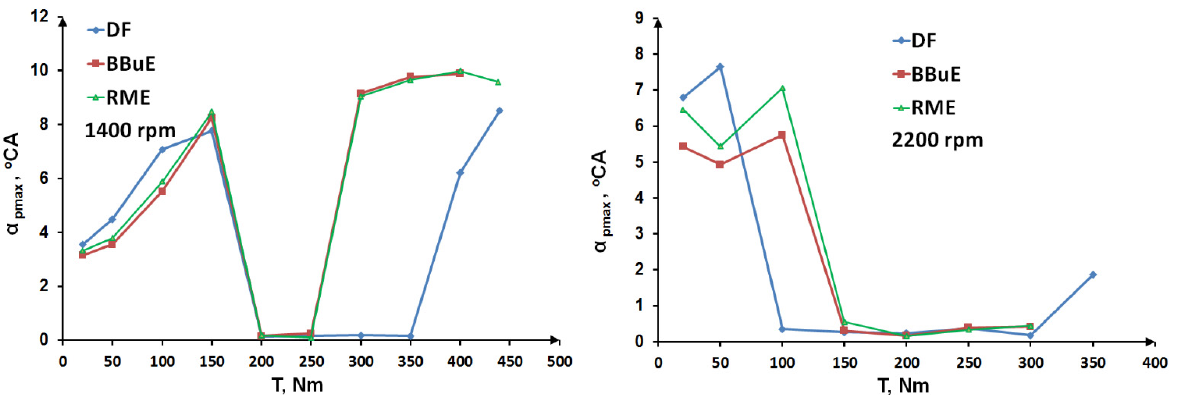
Figure 7. Angular values of the engine crankshaft at which the maximum combustion pressures.